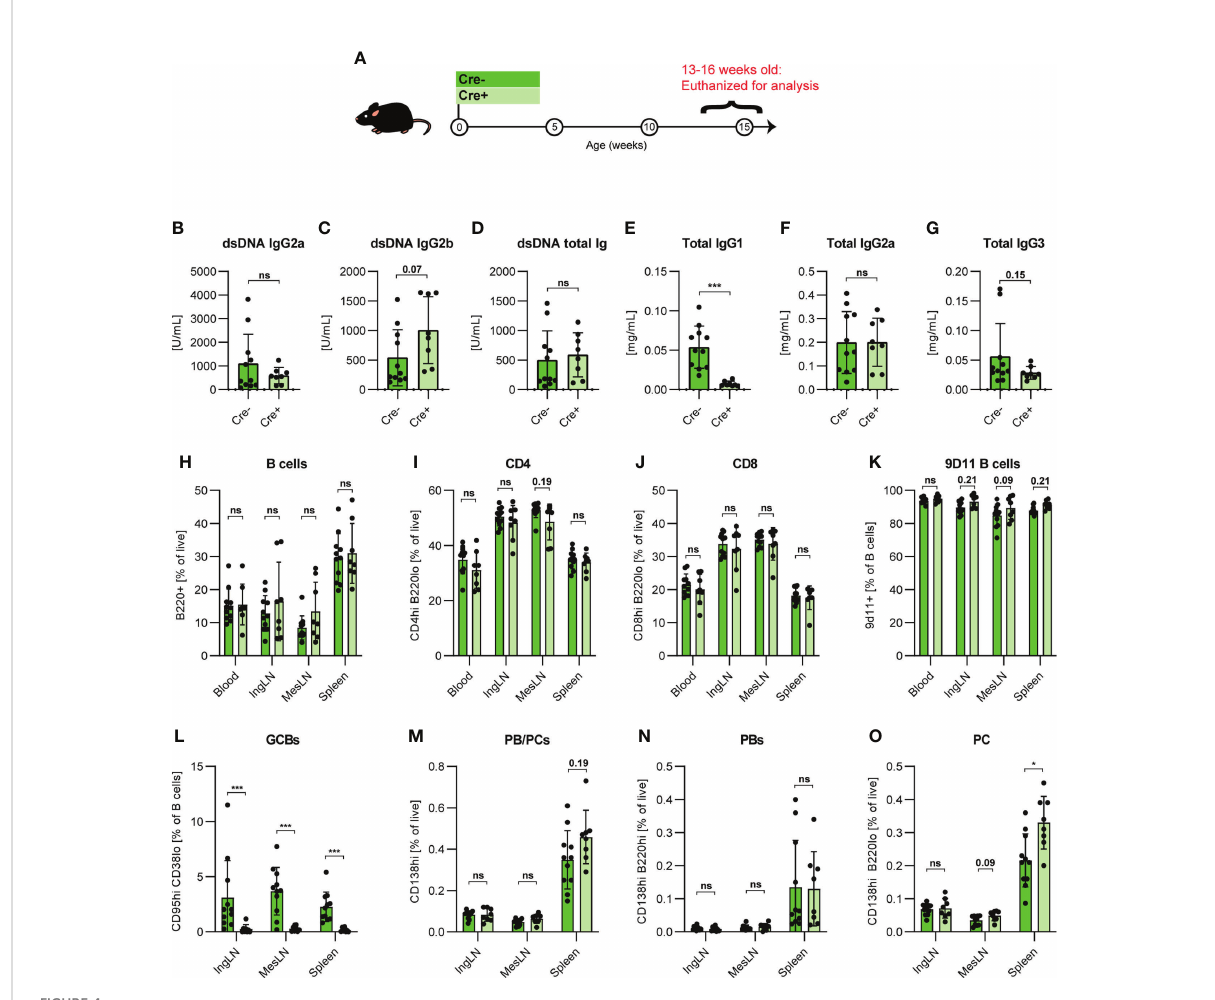
FIGURE 4 GC block causes increased PB/PCs levels in adolescent 564Igi mice. (A) Schematic overview of experimental setup: 564Igi-Bcl-6 fl x/ fl x (Cre-, dark green, n=11) and 564Igi-Aicda-Cre Bcl-6 fl x/ fl x (Cre+, light green, n=8) mice. (B) Anti-dsDNA IgG2a. (C) Anti-dsDNA IgG2b. (D) Anti-dsDNA total Ig. (E) Total IgG1. (F) Total IgG2a. (G) Total IgG3. Unpaired t-test or Mann-Whitney ’ s test was used was used to analyze TRIFMA data. (H) Flow cytometry analyses of B cell frequencies (B220 + CD4 - CD8 - of live, singlet lymphocytes) in blood, IngLN, MesLN, and spleen. (I) As H, but CD4 T cells (CD4 + B220 - ). (J) As H, but CD8 T cells (CD8 + B220 - ). (K) As H, but 9D11 B cell frequencies (9D11 + ). (L) As H, but GCB frequencies (CD95 hi CD38 lo ). (M) As H, but PB and PC frequencies (CD138 hi ), (N) As H, but PB frequencies (CD138 hi B220 hi ), (O) As H, but PC frequencies (CD138 hi B220 lo ). Data are pooled from two independent experiments. Bar graphs show mean ± SD. Two-way ANOVA with Holm-Sidak ’ s post hoc test was used to analyze the data. ns = p ≥ 0.05, *p < 0.05, ***p <